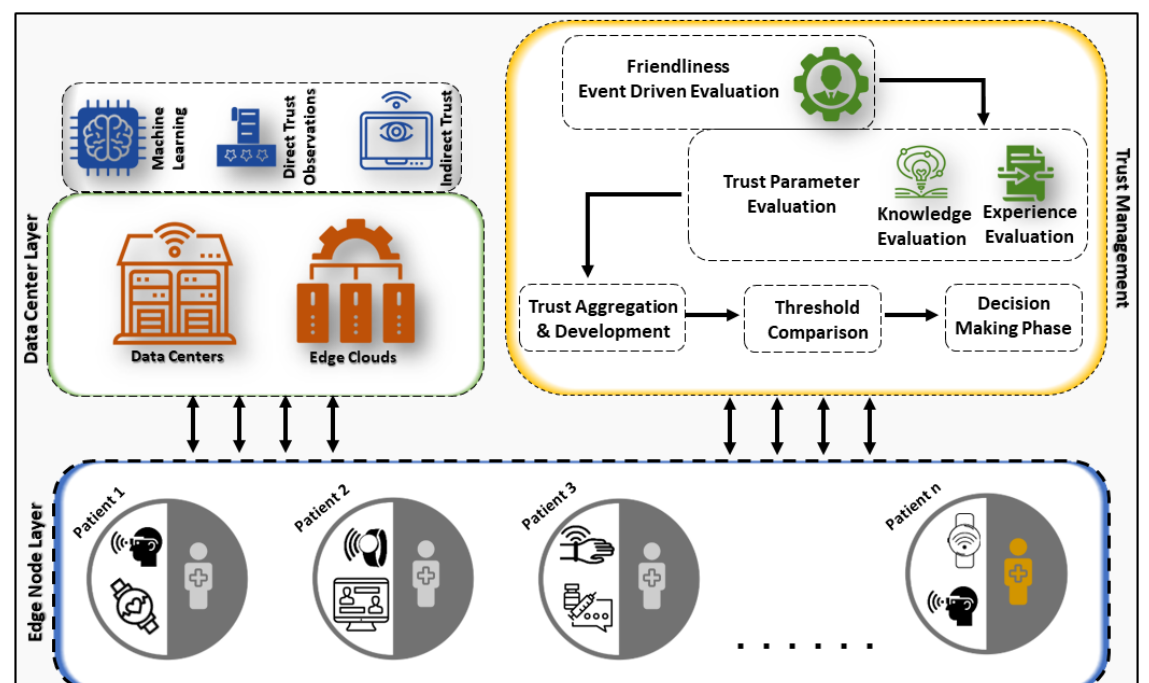
Figure 2. The proposed EdgeTrust